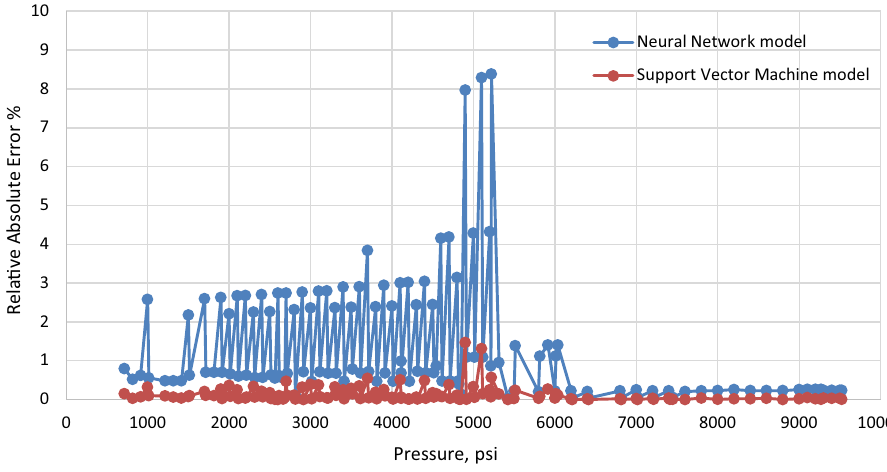
Fig. 15 Error comparison between neural network and support vector machine